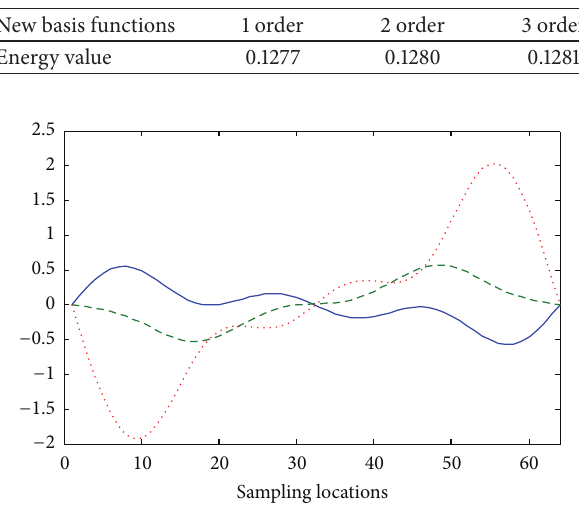
Table 2: Energy value of the dynamical systems based on new basis functions.